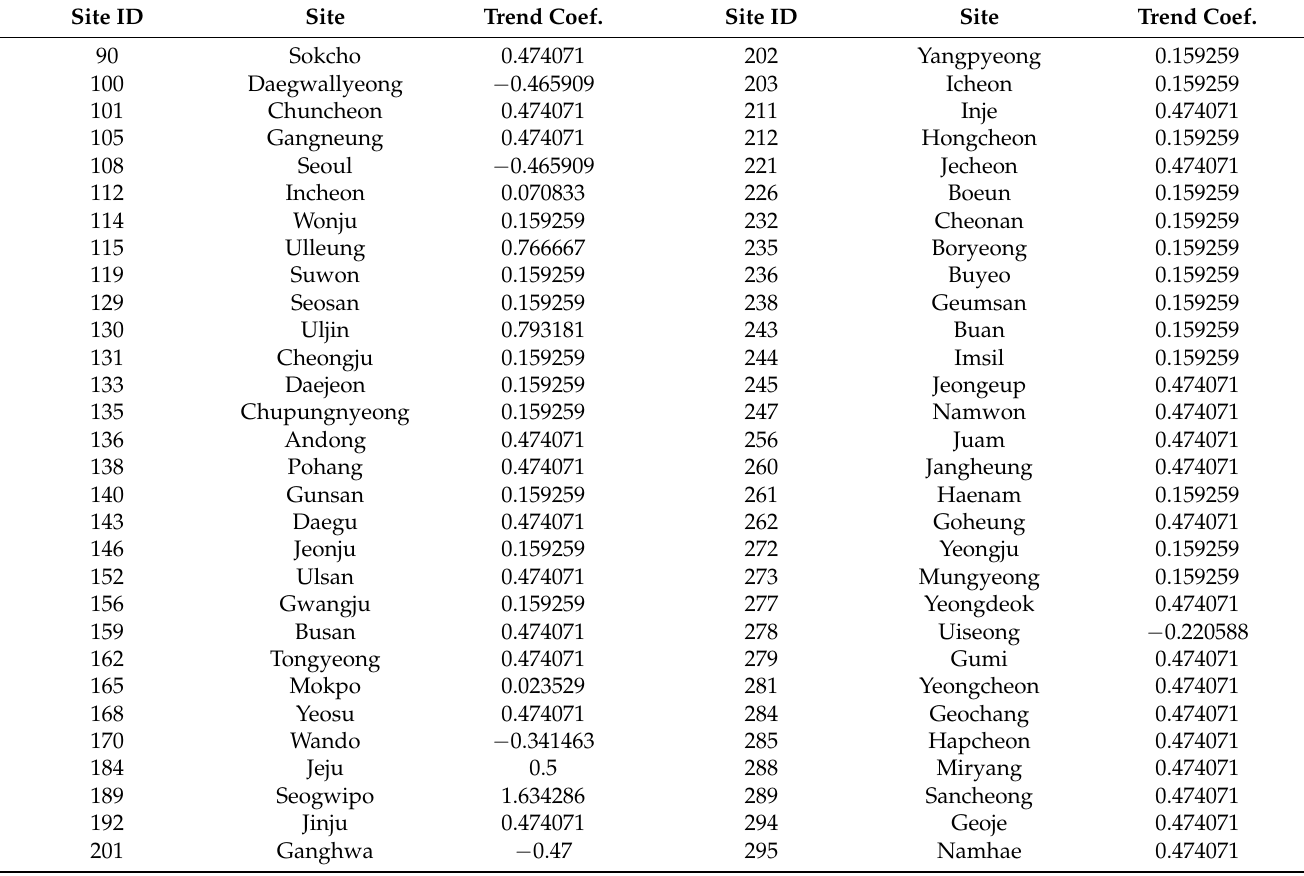
Table A2. Trend coefficients of